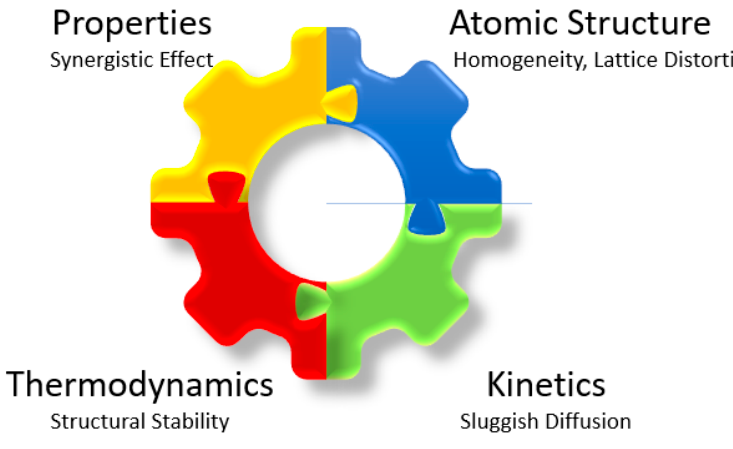
Figure 1. The four core effects of CCAs [27,30].